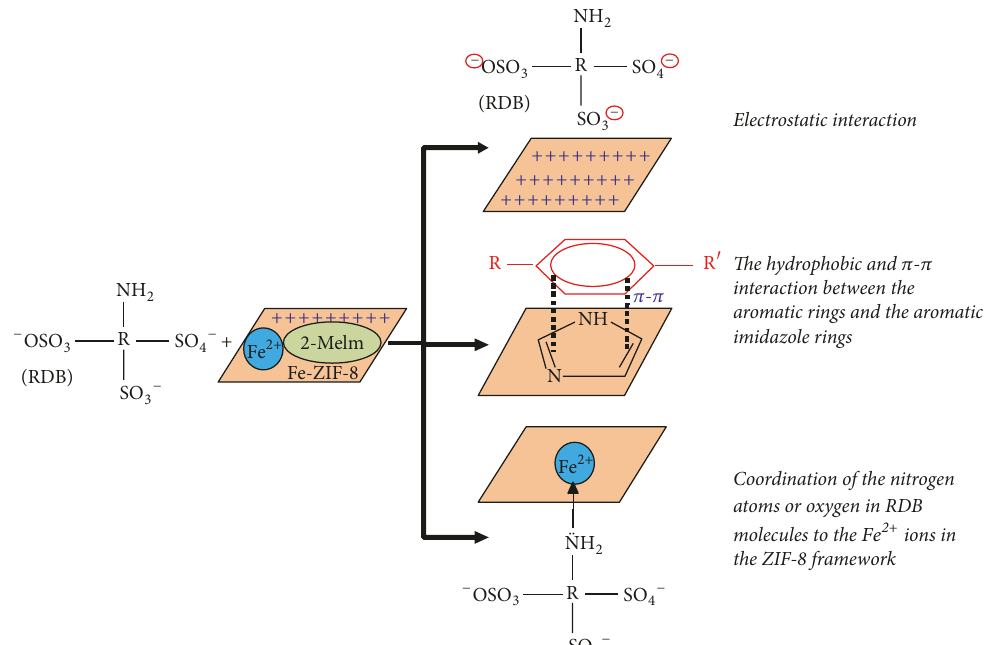
Figure 11: The proposed mechanism of RDB adsorption onto ZIF-8 or Fe-ZIF-8 at pH < pH